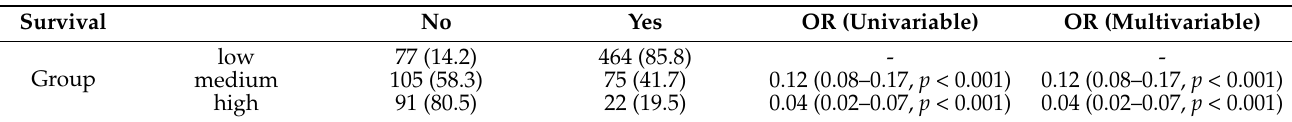
Table 6. The overall survival odds ratios for GRAM risk stratification.